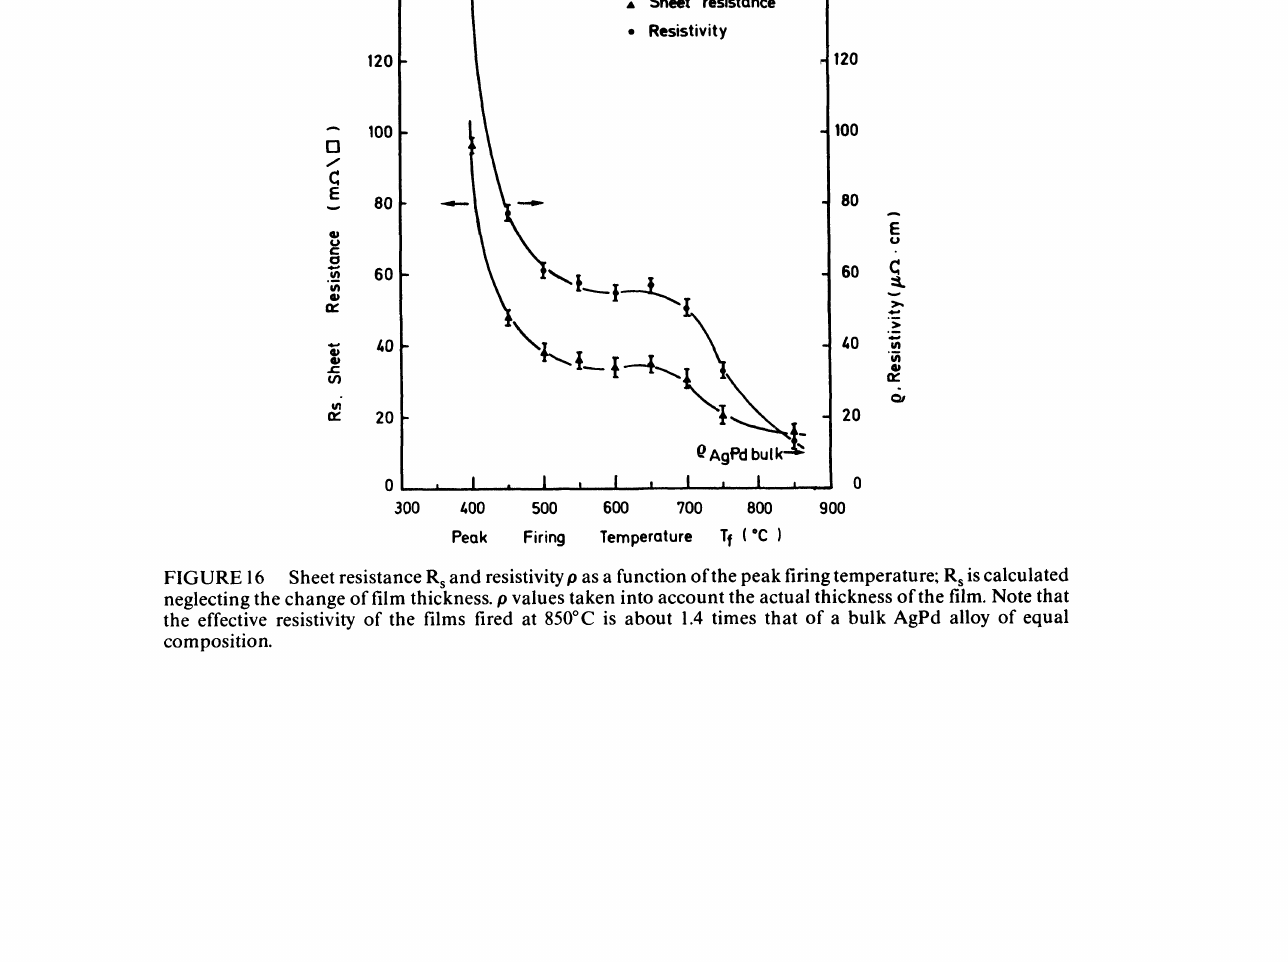
FIGURE 15 Atomic concentration of AI and Bi in samples 25 /.tm-thick, fired at 850C and thinned by mechanical lapping at different thickness.